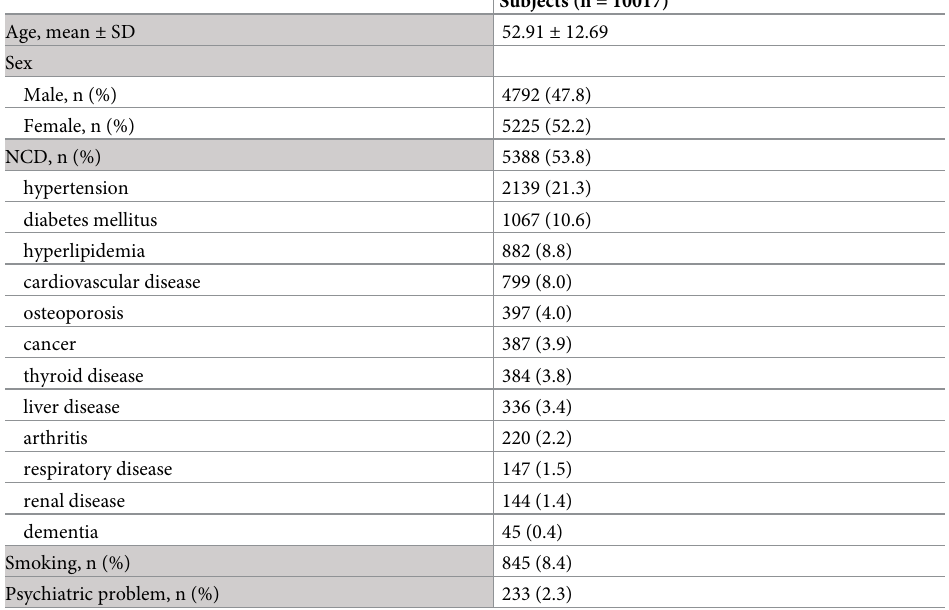
Table 1. Patient